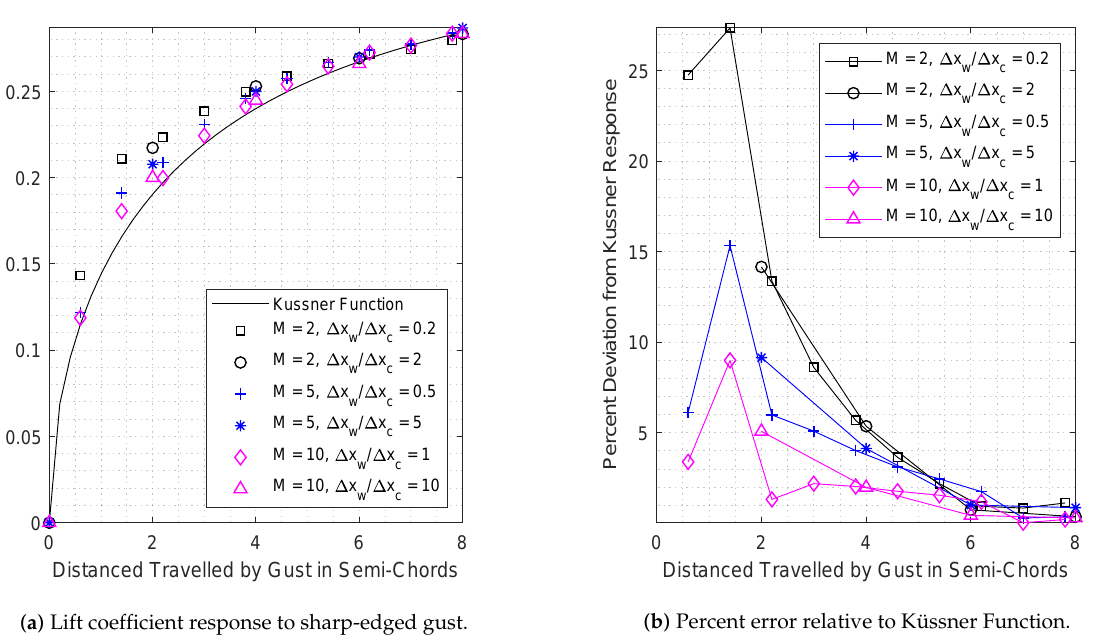
Figure 7. DDE prediction of lift response of a 2D wing section as it encounters a sharp-edged gust.